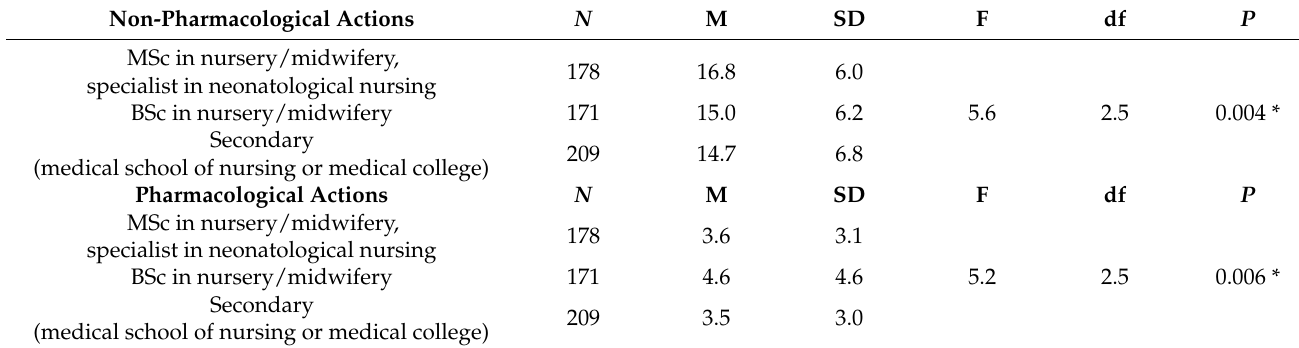
Table 6. Educational level vs. non-pharmacological and pharmacological actions.